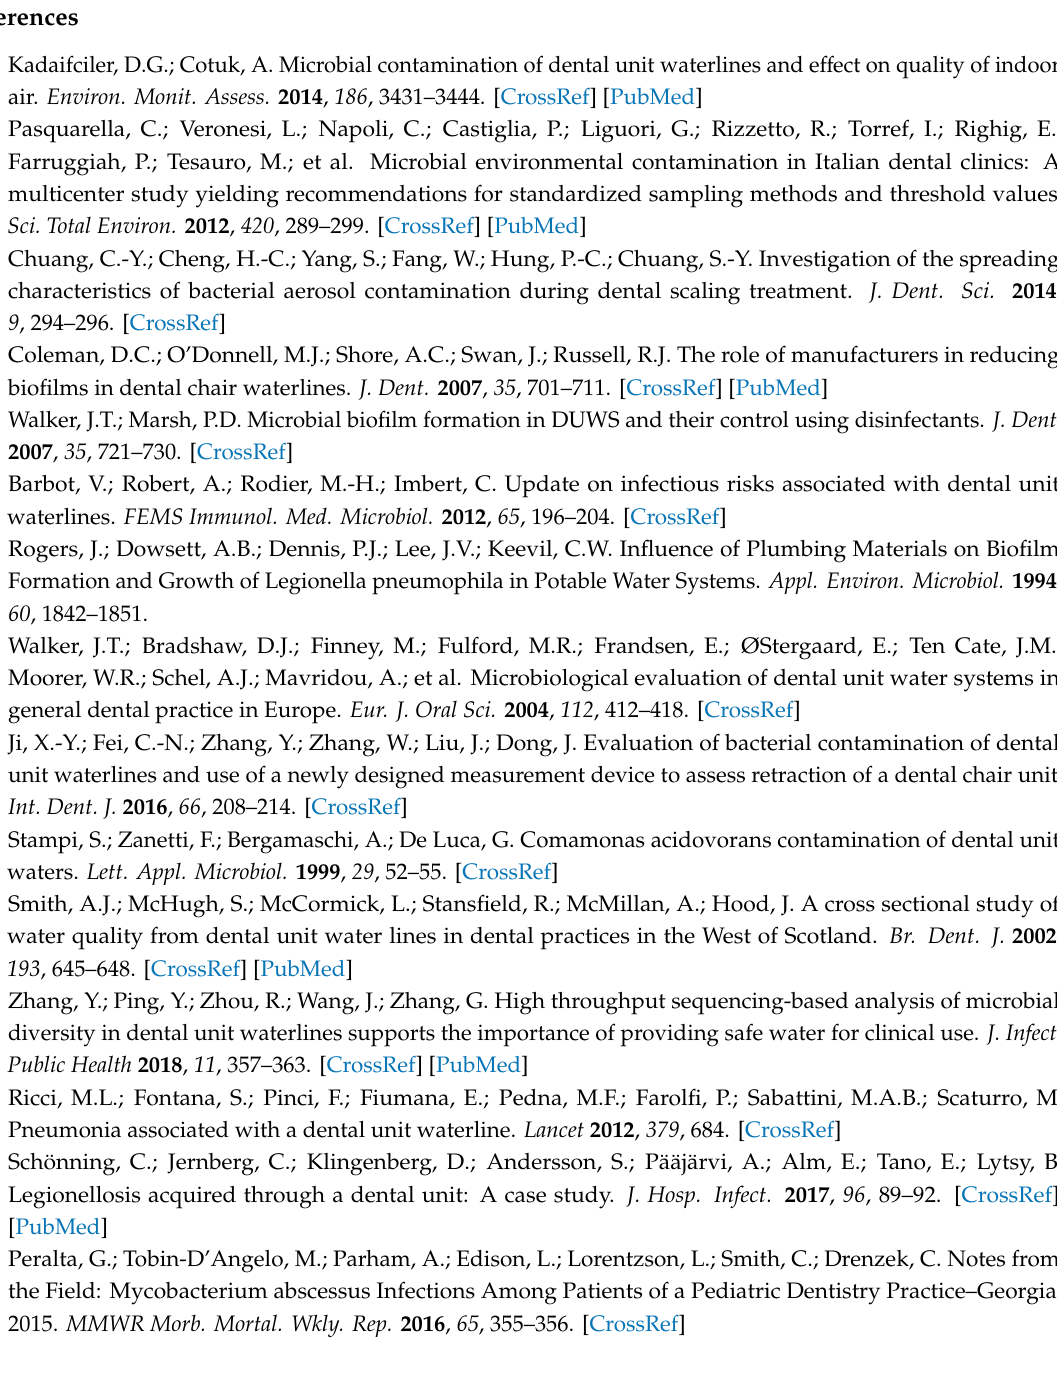
Figure S1: Makes of the 223 dental care units studied in Eastern France in